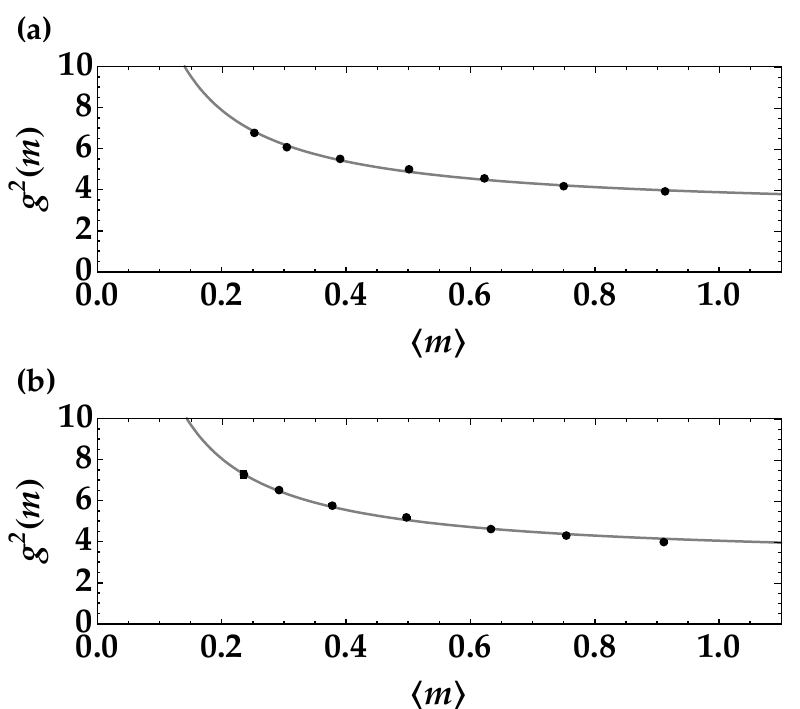
Figure 5. Second-order autocorrelation function g 2 ( m ) as a function of the mean number of detected photons reconstructed at the two BS outputs. Black dots and error bars: experimental data; gray curves: theoretical fitting functions according to Equation (7), in which µ f = 1.22, while µ s is the only fitting parameter. The obtained values are: µ s = 1.72 ± 0.05 in panel ( a ) and µ s = 1.48 ± 0.05 in panel ( b ).